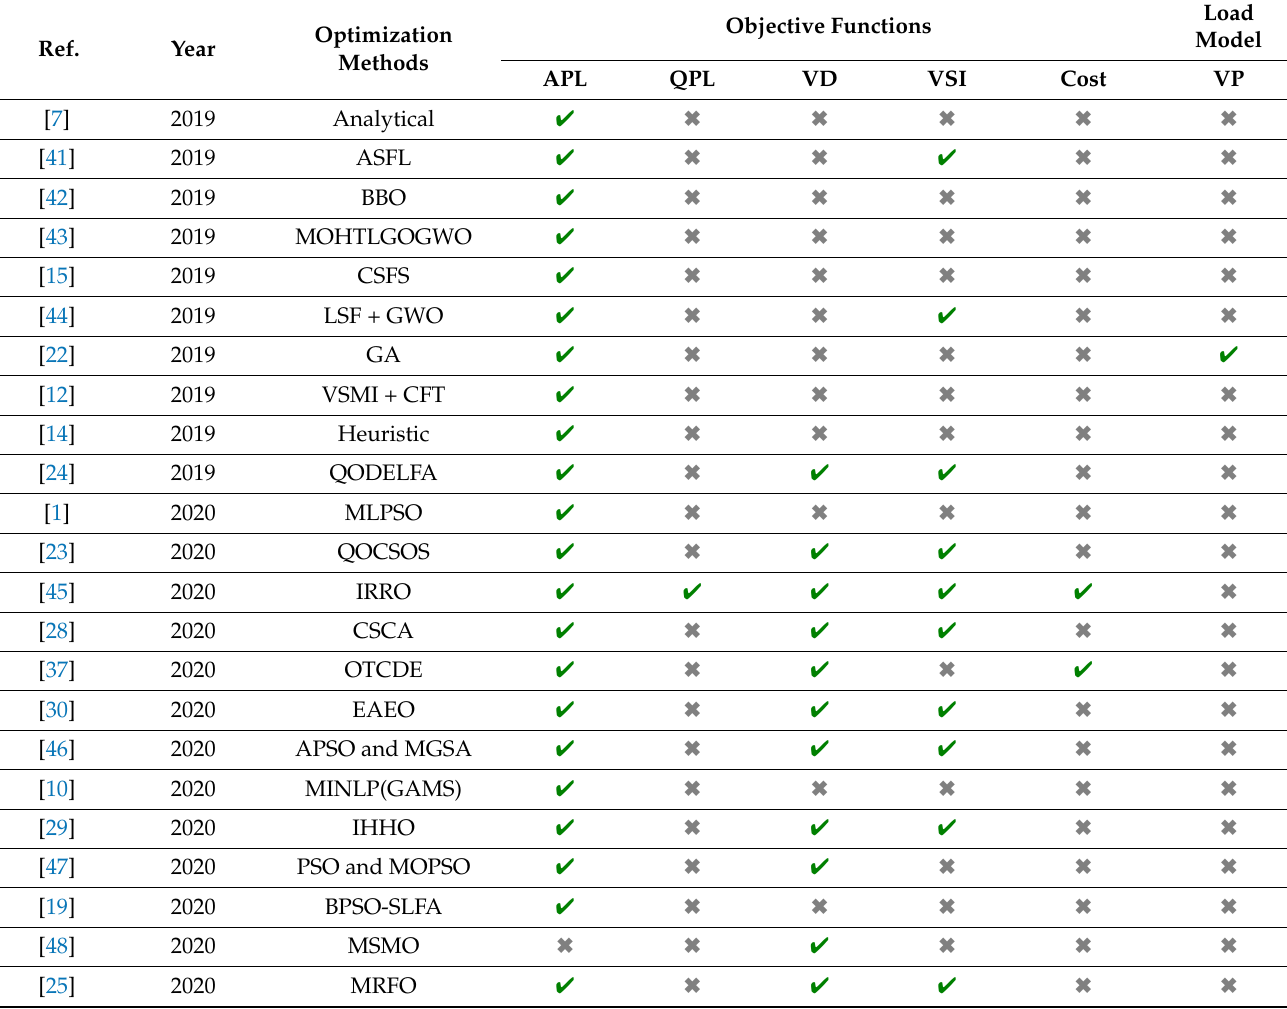
Table 1. Summary of optimization techniques used for OADG in RDNs.